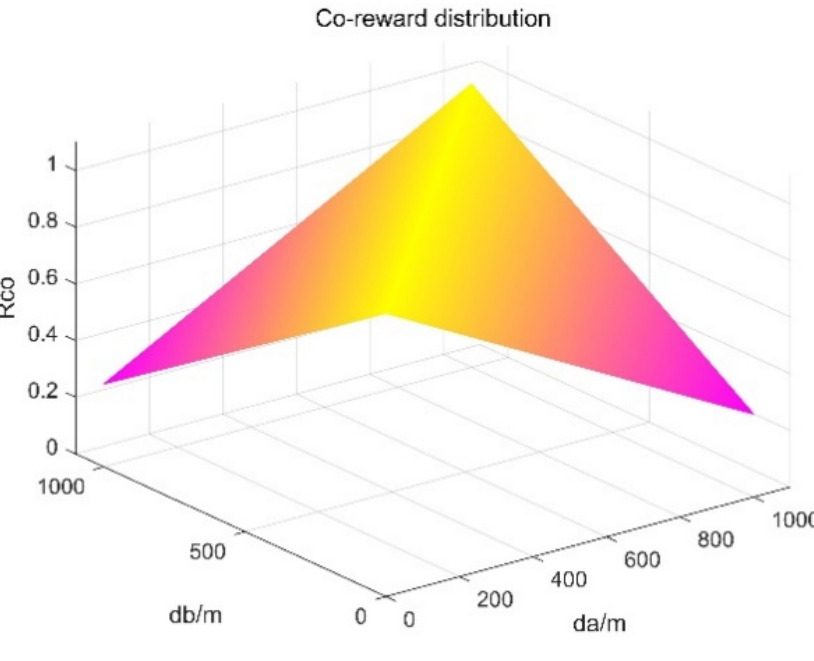
Figure 6. Co-reward distribution.